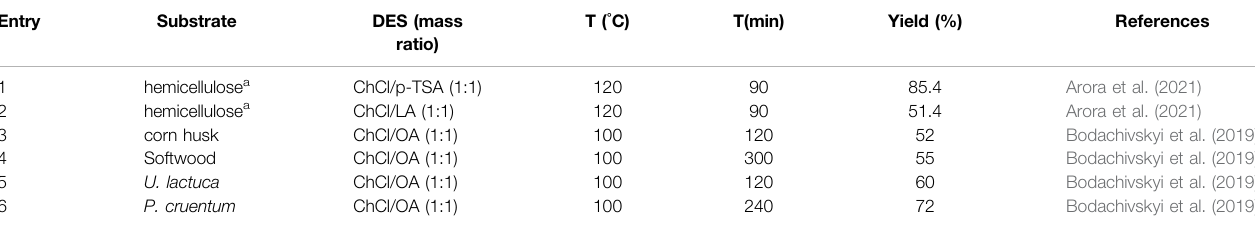
TABLE 2 | Furfural production in a neat DES system (no